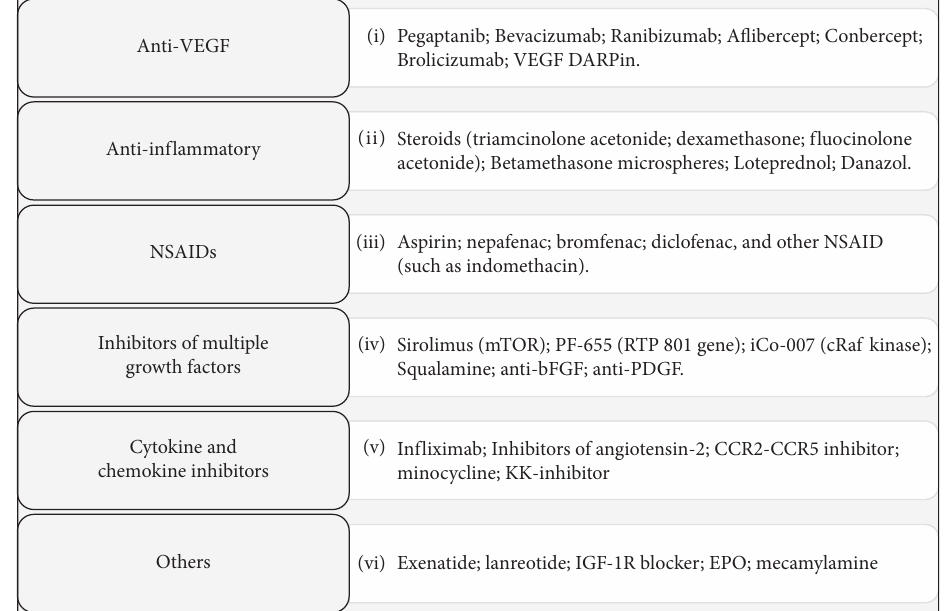
Figure 2: Overview of the medical treatment options for diabetic macular edema (adapted from Urias et al. [15]). NSAIDS: nonsteroidal anti-inflammatory drug; VEGF: vascular endothelial growth factor; DARPin: designed ankyrin repeat protein; FGF: fibroblast growth factor beta; PDGF: platelet-derived growth factor; CCR: chemokine receptor; IGF-1: insulin-like growth factor-1; EPO: erythropoietin.